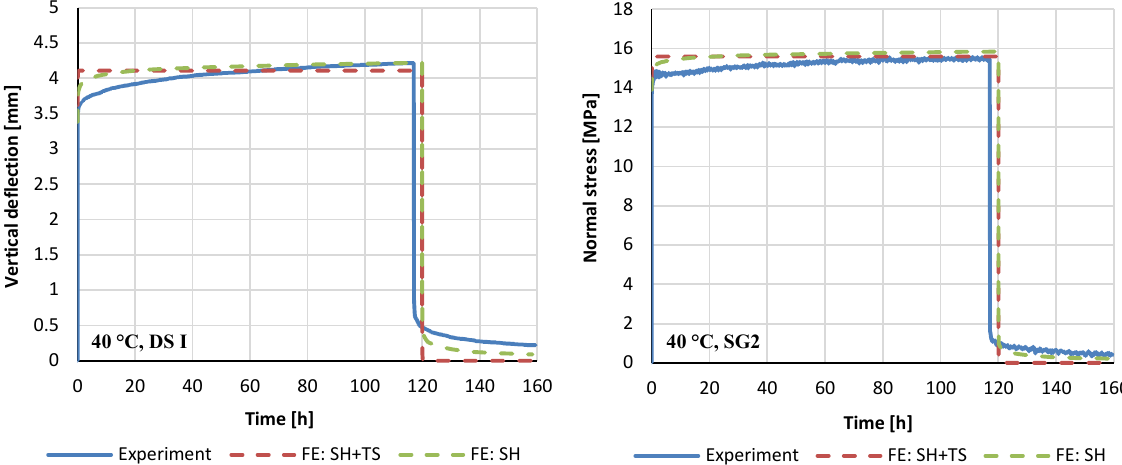
Fig. 16 Comparison of experimental and numerical midspan displacements by DS I and normal stresses by SG2 at 40 °C.